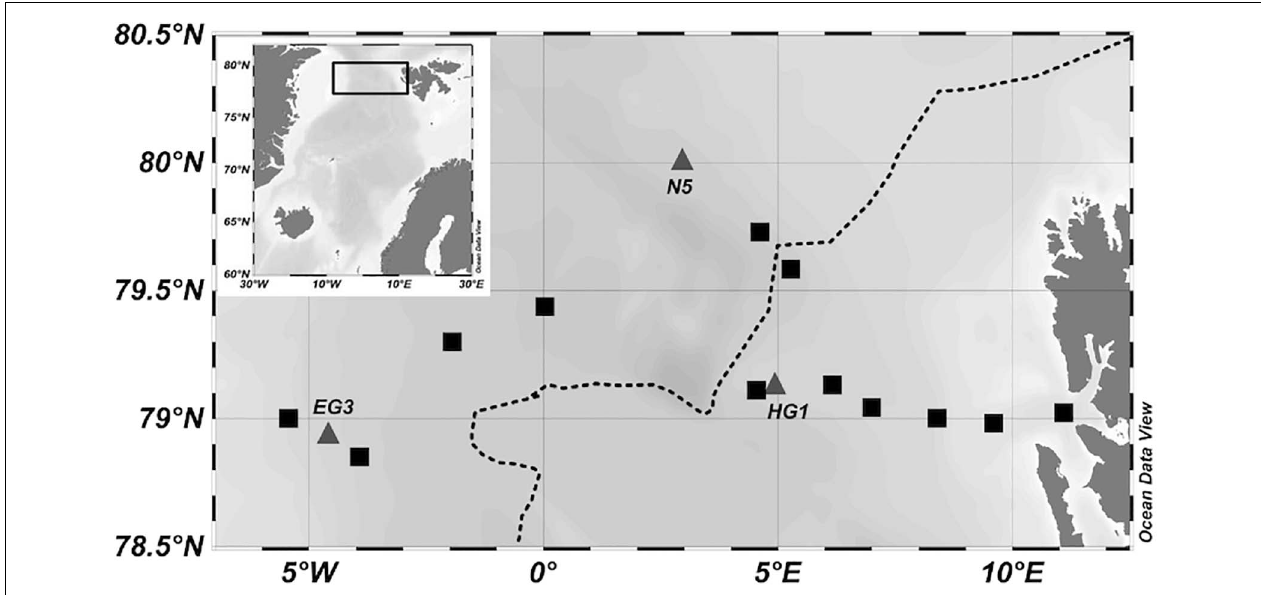
FIGURE 1 | Map of stations sampled for dissolved and particulate compounds (black squares and gray triangles). Size fractionation was performed on stations EG3, HG1, and N5, depicted as gray triangles. The dotted black line indicates the sea ice monthly median edge retrieved from https://www.meereisportal.de (Spreen et al.,